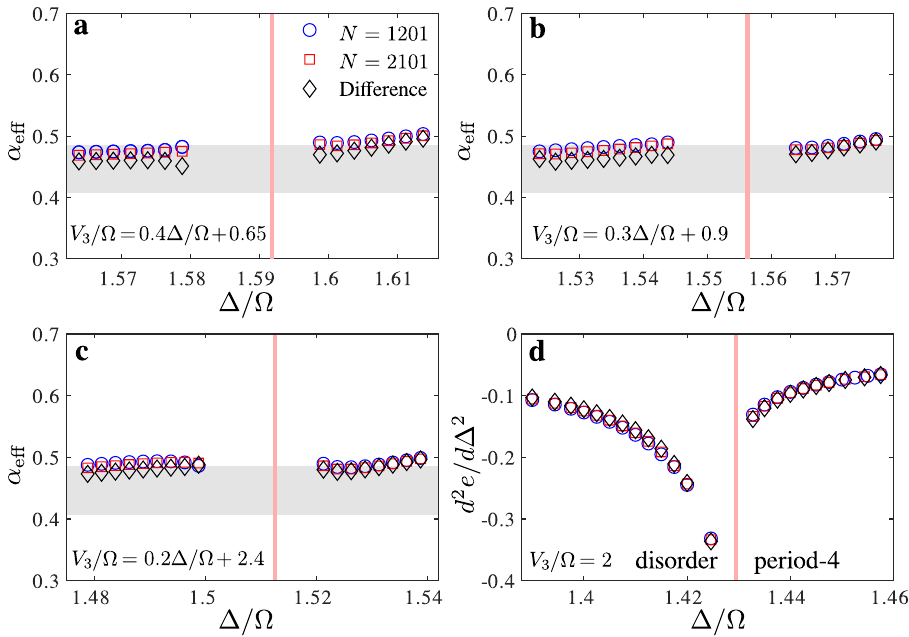
Fig. 6 Behavior of the second derivative of the energy close to the transition line. Effective critical exponent α across a the Ashkin – Teller point and b , c the chiral transition across oblique cuts perpendicular to the critical line. d Second derivative of the energy per site with respect to Δ / Ω for V 3 / Ω = 2 around the Pokrovsky – Talapov transition. The results are extracted from the ground-state energy of a chain with N = 1201 sites (blue circles) and N = 2101 sites (red squares), and from the difference between the two (black diamonds). The gray area indicates the expected value of α for a critical exponent ν ≈ 0.78 ±